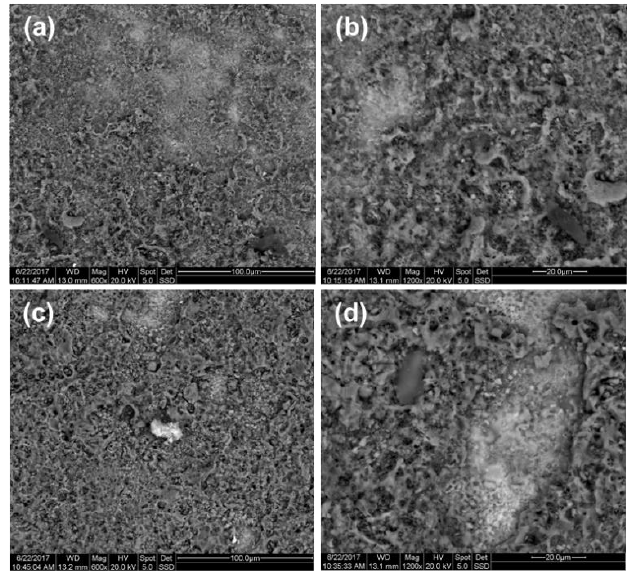
Figure 4. Surface SEM images of prepared coating by micro-arc oxidation with different time after their surface loose layers were ground off: ( a , b ) MAO-1 and ( c , d ) MAO-2 coating.